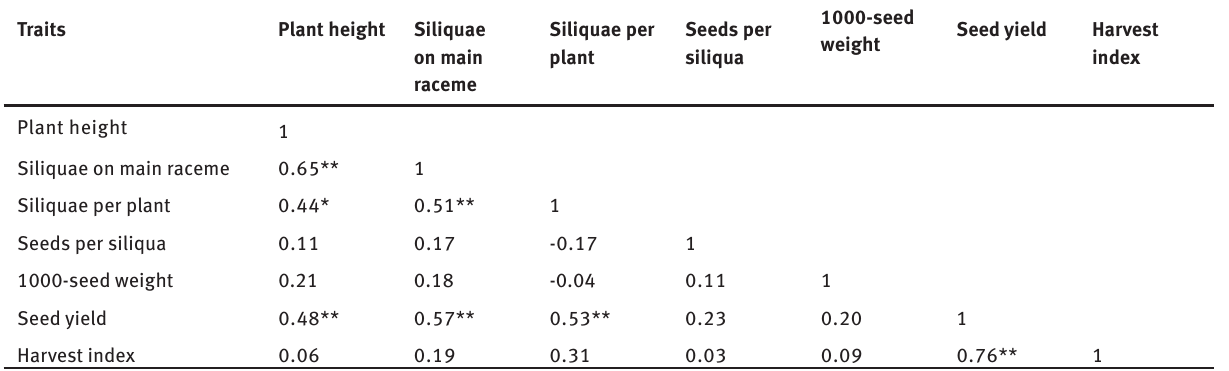
Table 4: Pearson correlation coefficient estimates of seed yield and its components based on means of the crosses